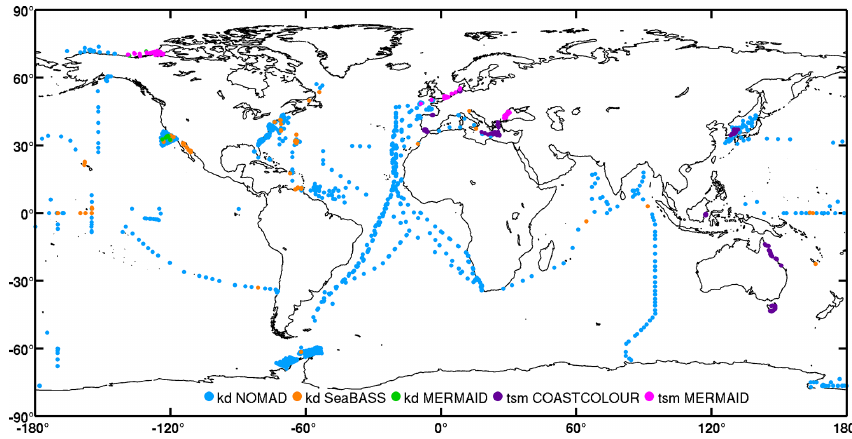
Figure 15. Global distribution of diffuse attenuation coefficient for downward irradiance (“kd”) and total suspended matter (“tsm”) per data set in the final table. The “tsm” and “kd” points from MERMAID overlap each other in west Black Sea ( ∼ 40 ◦ N, 30 ◦ E) and Arctic ( ∼ 70 ◦ N, 120 ◦